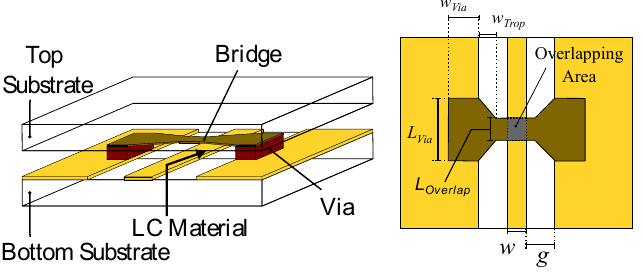
Figure 26. Schematic of a LC varactor build up by a metal bridge on the top substrate ( left ), connecting the two ground planes of the CPW by vias and the signal line on the bottom substrate, filled with LC. Top view ( right ) [175].